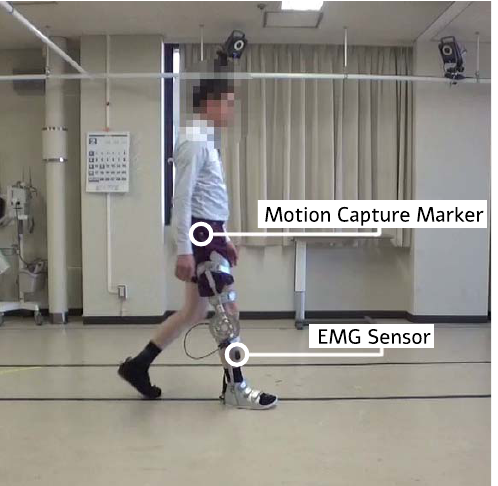
Figure 8. A healthy participant performing the experiment while wearing the device. One example of the motion capture marker and EMG sensor have been highlighted for each. Faces have been blurred for